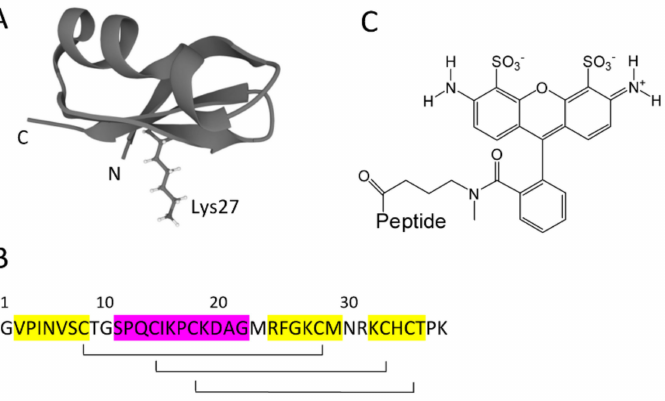
Figure 1. Structure of AgTx2 and Atto488. ( A ) Secondary structure of AgTx2 (PDB ID: 1AGT). The residue Lys27 that occludes a channel pore is shown in a stick-and-ball presentation. N and C denote the N- and C- termini of AgTx2. ( B ) Amino acid sequence of AgTx2 and distribution of secondary structure elements (magenta—residues of α -helix, yellow—residues of β -strands). Brackets connect disulfide-bonded cysteine residues. ( C ) Structure of Atto488 fluorophore.